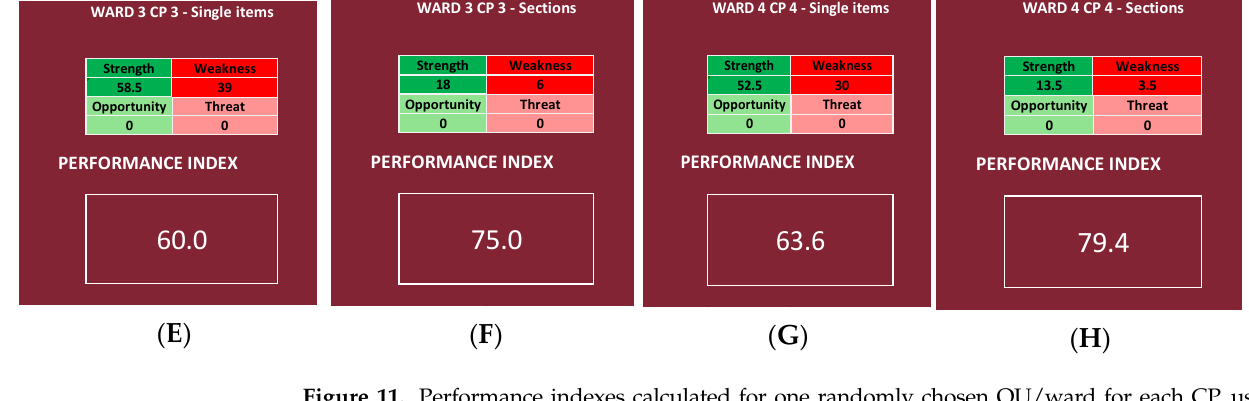
Figure 11. Performance indexes calculated for one randomly chosen OU/ward for each CP, using the mean scores of every item of the questionnaire ( A , C , E , G ) and using the mean scores of every Questionnaire Section ( B , D , F , H ). For Ward 1 of CP1, the deeper analysis is shown in ( A ) and the shallower one in ( B ); for Ward 2 of CP2, the deeper analysis is shown in ( C ) and the shallower one in ( D ); for Ward 3 of CP3, the deeper analysis is shown in ( E ) and the shallower one in ( F ); lastly, for Ward 4 of CP4, the deeper analysis is shown in ( G ) and the shallower one in ( H ).